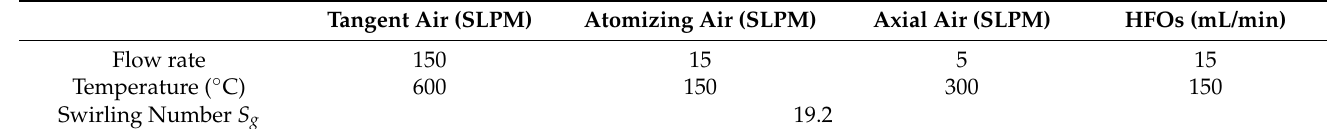
Table 3. Experimental